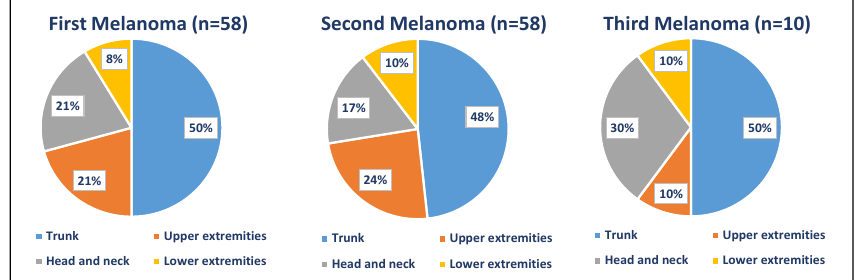
Figure 2. Anatomic location of first and subsequent primary melanomas. Table 2. Clinical and histopathological characteristics of multiple primary melanomas. Regarding histopathological characteristics of MPM, superficial spreading melanoma (SSM) was the most common histologic subtype in first (35/58; 60.3%) and second (33/58; 56.9%) melanomas, while lentigo maligna (LM) histological subtype had the highest pro- portion in third melanomas (9/10; 90%) (Table 2 and Figure 3). An increasing rate of LM subtype within subsequent melanomas was observed. Moreover, 34 (58.6%) second melanomas had the same histologic subtype as the first